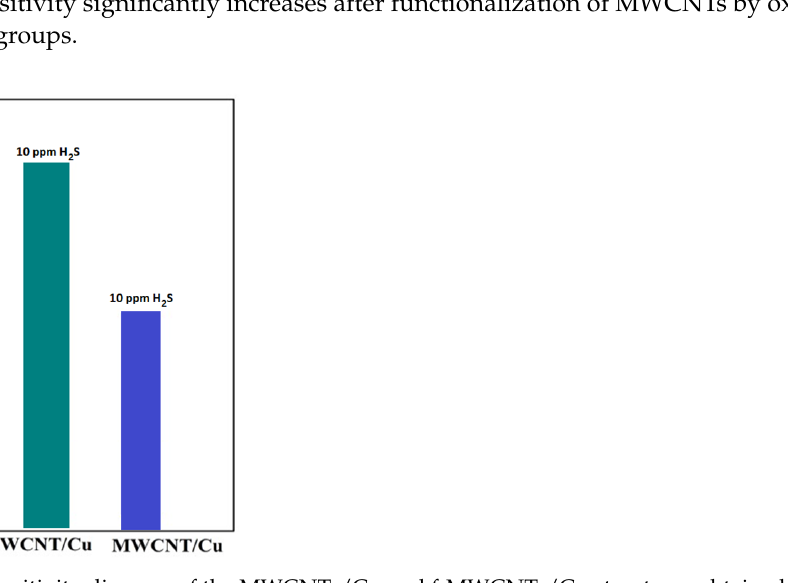
Figure 10. Sensitivity diagram of the MWCNTs/Cu and f-MWCNTs/Cu structures obtained by the physical method (in the H 2 S medium).